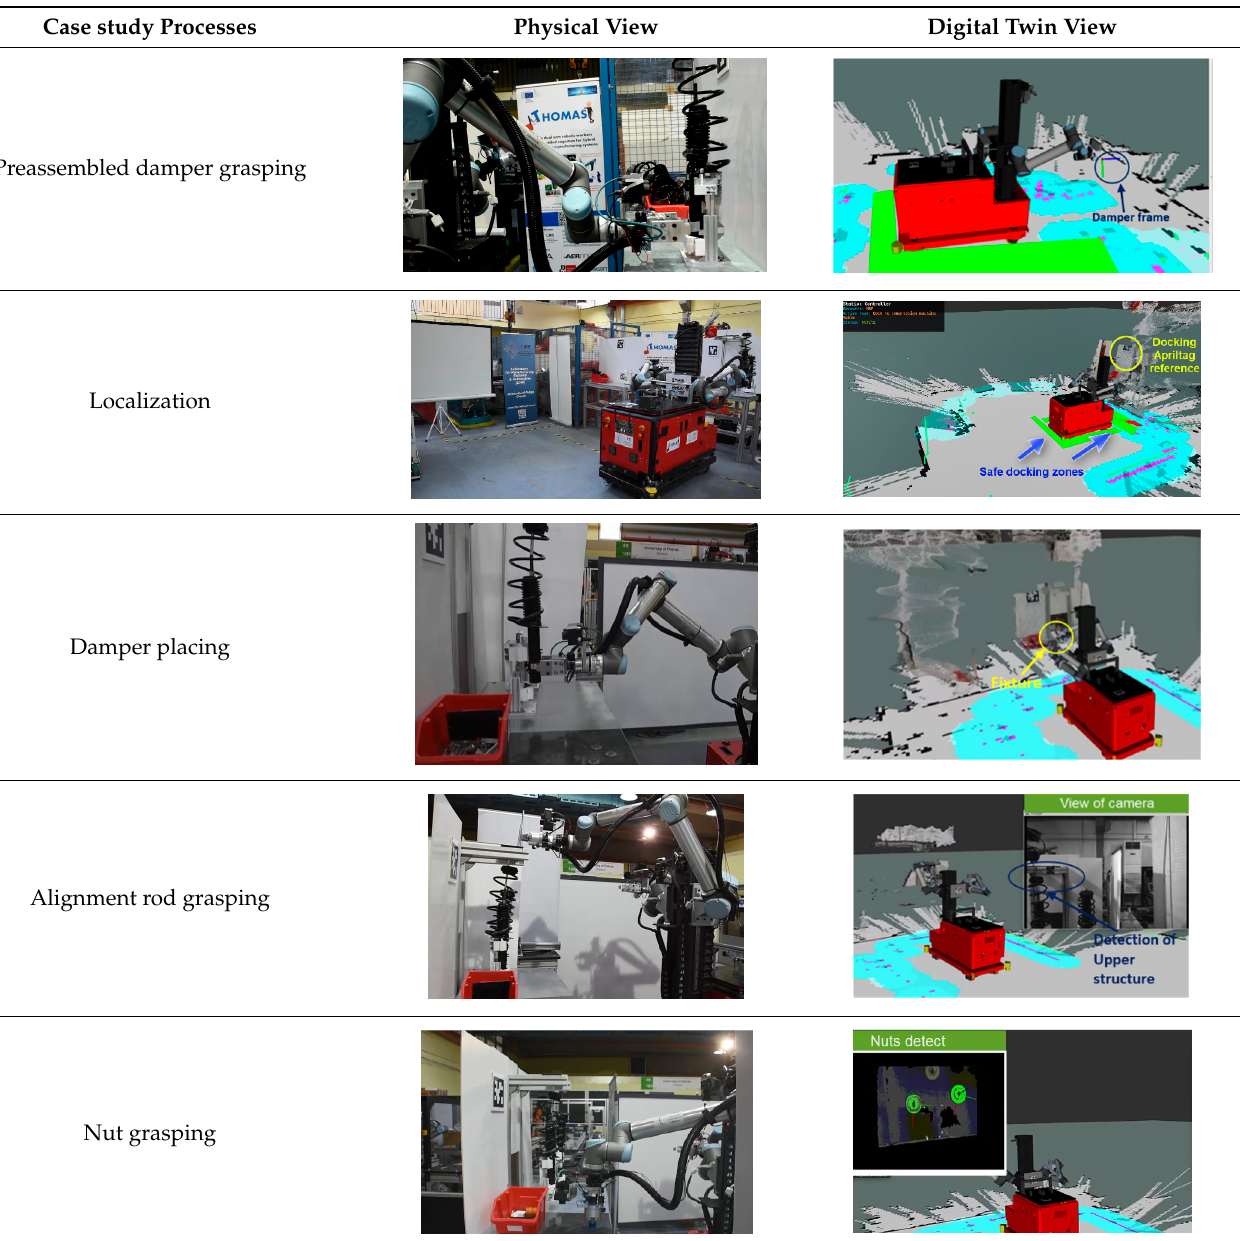
Table 2. Views of the case study processes .